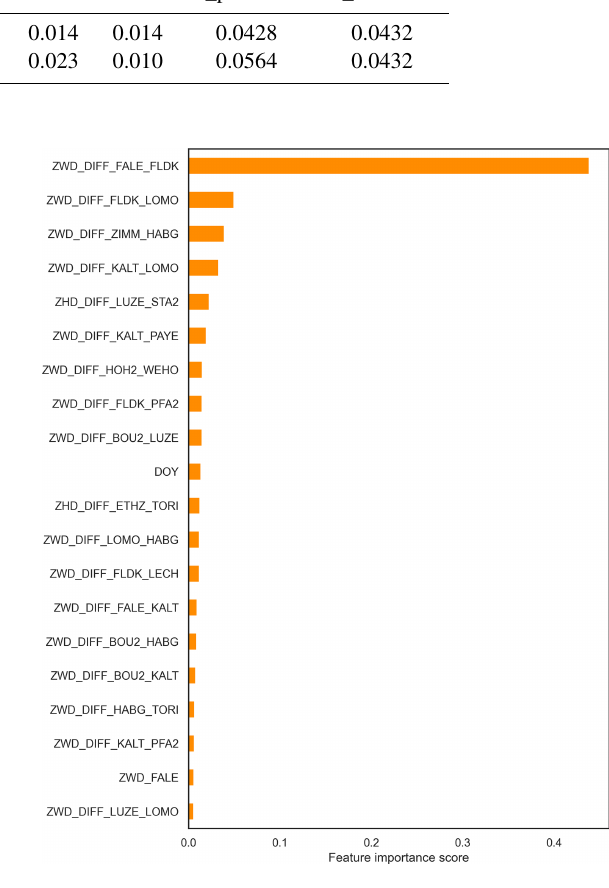
Figure 5. Feature importance score of the 20 top predictors for the GB algorithm for